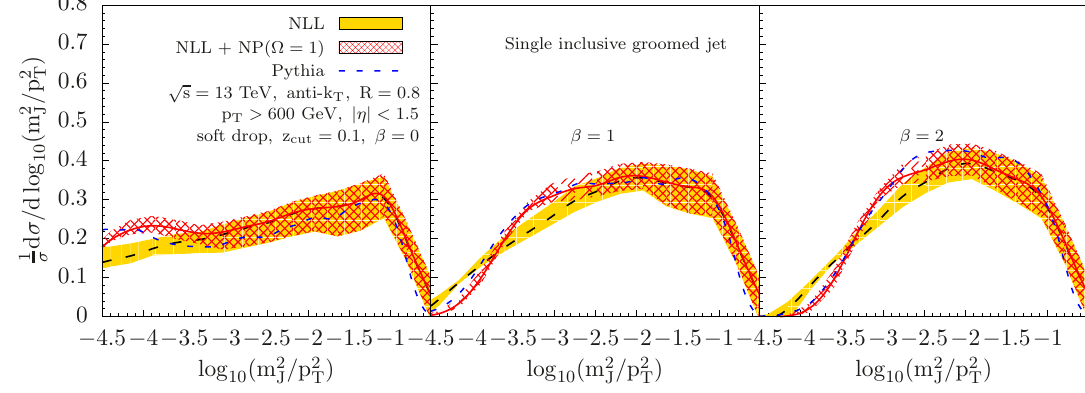
Figure 6 . The theoretical predictions for the soft drop groomed jet mass distribution for single inclusive jet production pp jet + X at p s = 13 TeV. The observed jets are reconstructed ! through the anti- k T algorithm with a jet radius parameter of R = 0 : 8. The rapidity and transverse momentum intervals for the inclusive jet samples are chosen as (cid:17) < 1 : 5 and p T > 600 GeV and the j j soft threshold parameter is z cut = 0 : 1. The soft drop groomed jet mass distribution is normalized to the corresponding inclusive jet cross section and plotted as a function of log ( m 2 =p 2 ) for 10 J; gr T (cid:12) = 0 (left), (cid:12) = 1 (middle), and (cid:12) = 2 (right). The dashed black lines and yellow error bands show the purely perturbative NLL results, while the red lines and the red hatched bands are the NLL results but including the non-perturbative shape function according to eq. (4.6). We choose (cid:10) = 1 GeV for the parameter of non-perturbative shape function. The dashed blue lines are from Pythia